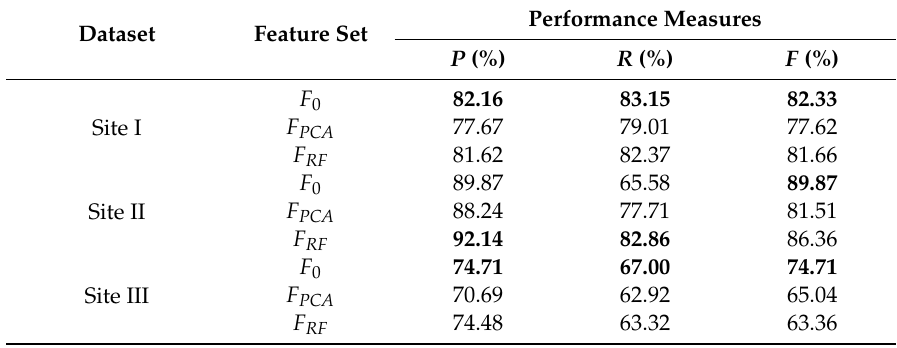
Table 12. The classification performance for di ff erent feature sets (classifier = RF, class distribution = unbalanced, R = 1.5 m). Three performance measures are shown in the table. P denotes the macro precision, R denotes the macro recall, and F denotes the macro F1. Bold denotes best results for each performance metric in each test